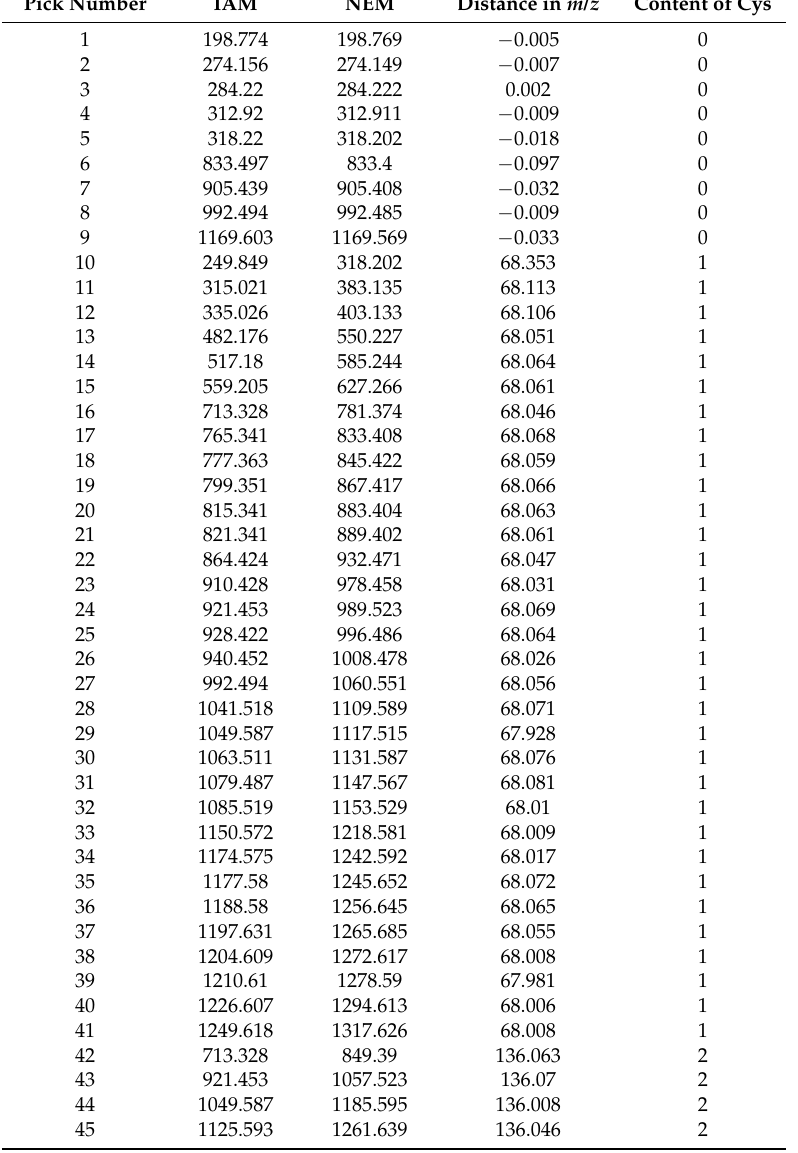
Table 1. m / z of picks in MALDI-TOF-MS